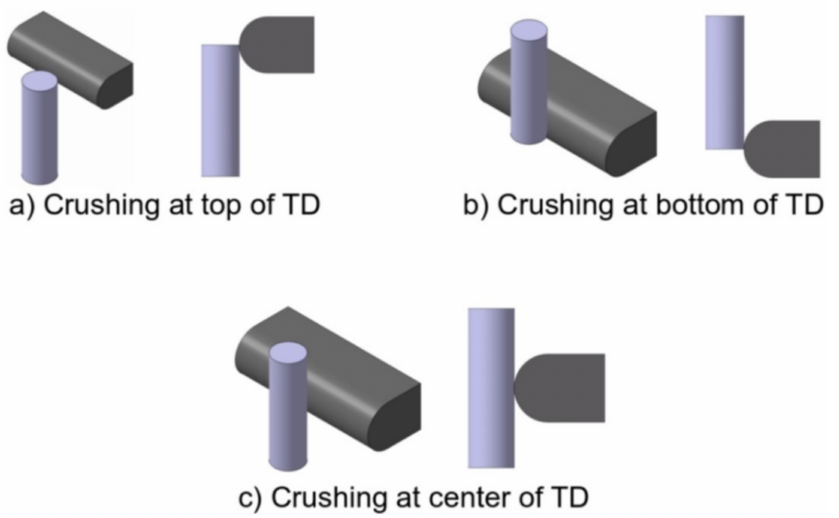
Figure 11. Point of contacts between impactor and TD from 3D view and front view, ( a ) top view; ( b ) bottom view; ( c ) centre